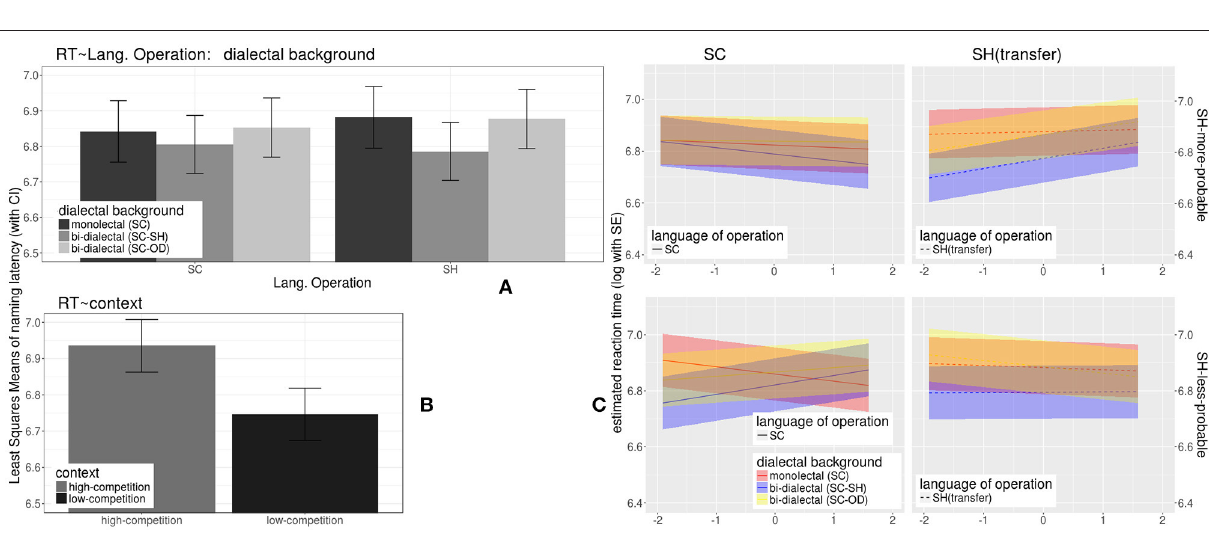
FIGURE 6 | Effects on reaction times in (correct) response to word trials during lexical identification test, modeled with LME method, including (1) the effects of dialectal background (color), in SC (A) (upper left panel, left cluster) and SH (A) (upper left panel, right cluster), (2) the effect of context provided by the distractor (B) (lower left panel), and (3) the linear interaction (C) (the four-figure grid in the right panel) of dialectal background (color), cross-dialectal similarity (along the vertical axes), the novel word’s morphological probability in SH (upper vs. lower subplots), and language of operation (left vs. right